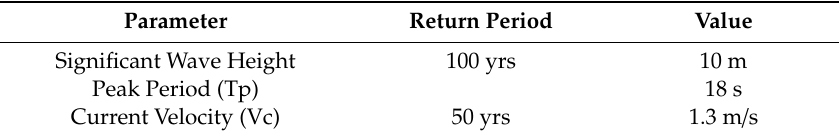
Table 1. Environmental conditions for the reference simulation